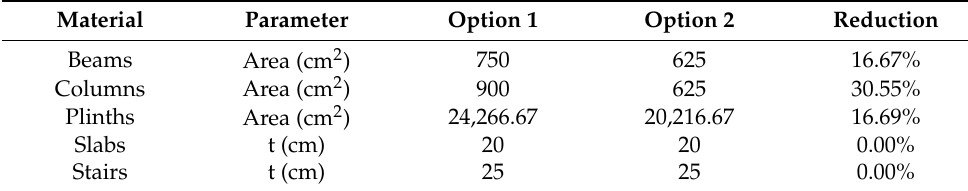
Table 6. Reduction percentage in structural